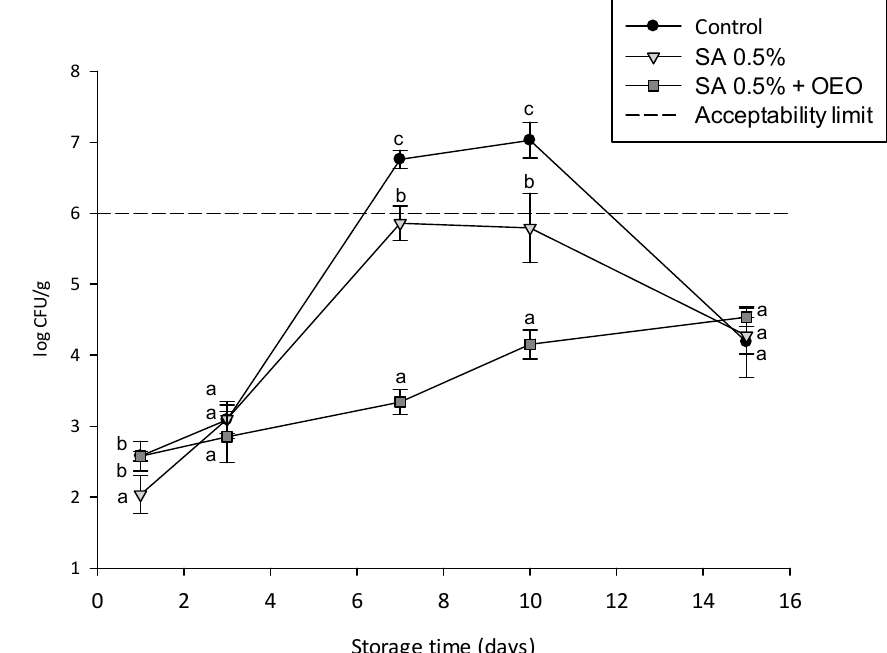
Figure 8. Total microbial count over a 14 days storage period at 24 ± 1 ◦ C of uncoated tomatoes (control, black circles) and tomatoes with an edible coating without (SA 0.5%, light grey triangles) and with OEO nanoemulsion (SA 0.5% + OEO, grey squares). Di ff erent letters denote significant di ff erences ( p < 0.05) among the di ff erent samples for each day of storage.